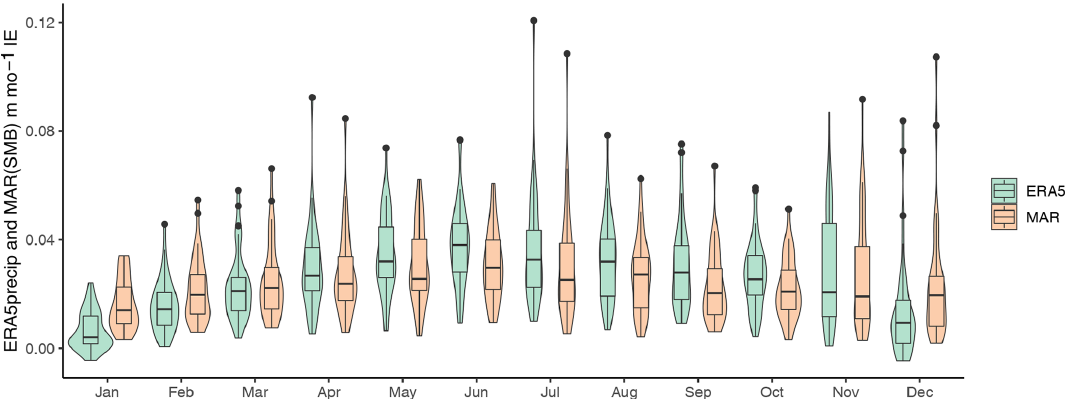
Figure 4. Climatology of surface mass balance and precipitation estimates at Mount Brown South from the Modele Atmospherique Regional (MAR(SMB)) and ERA5 (ERA5precip), respectively, over the period